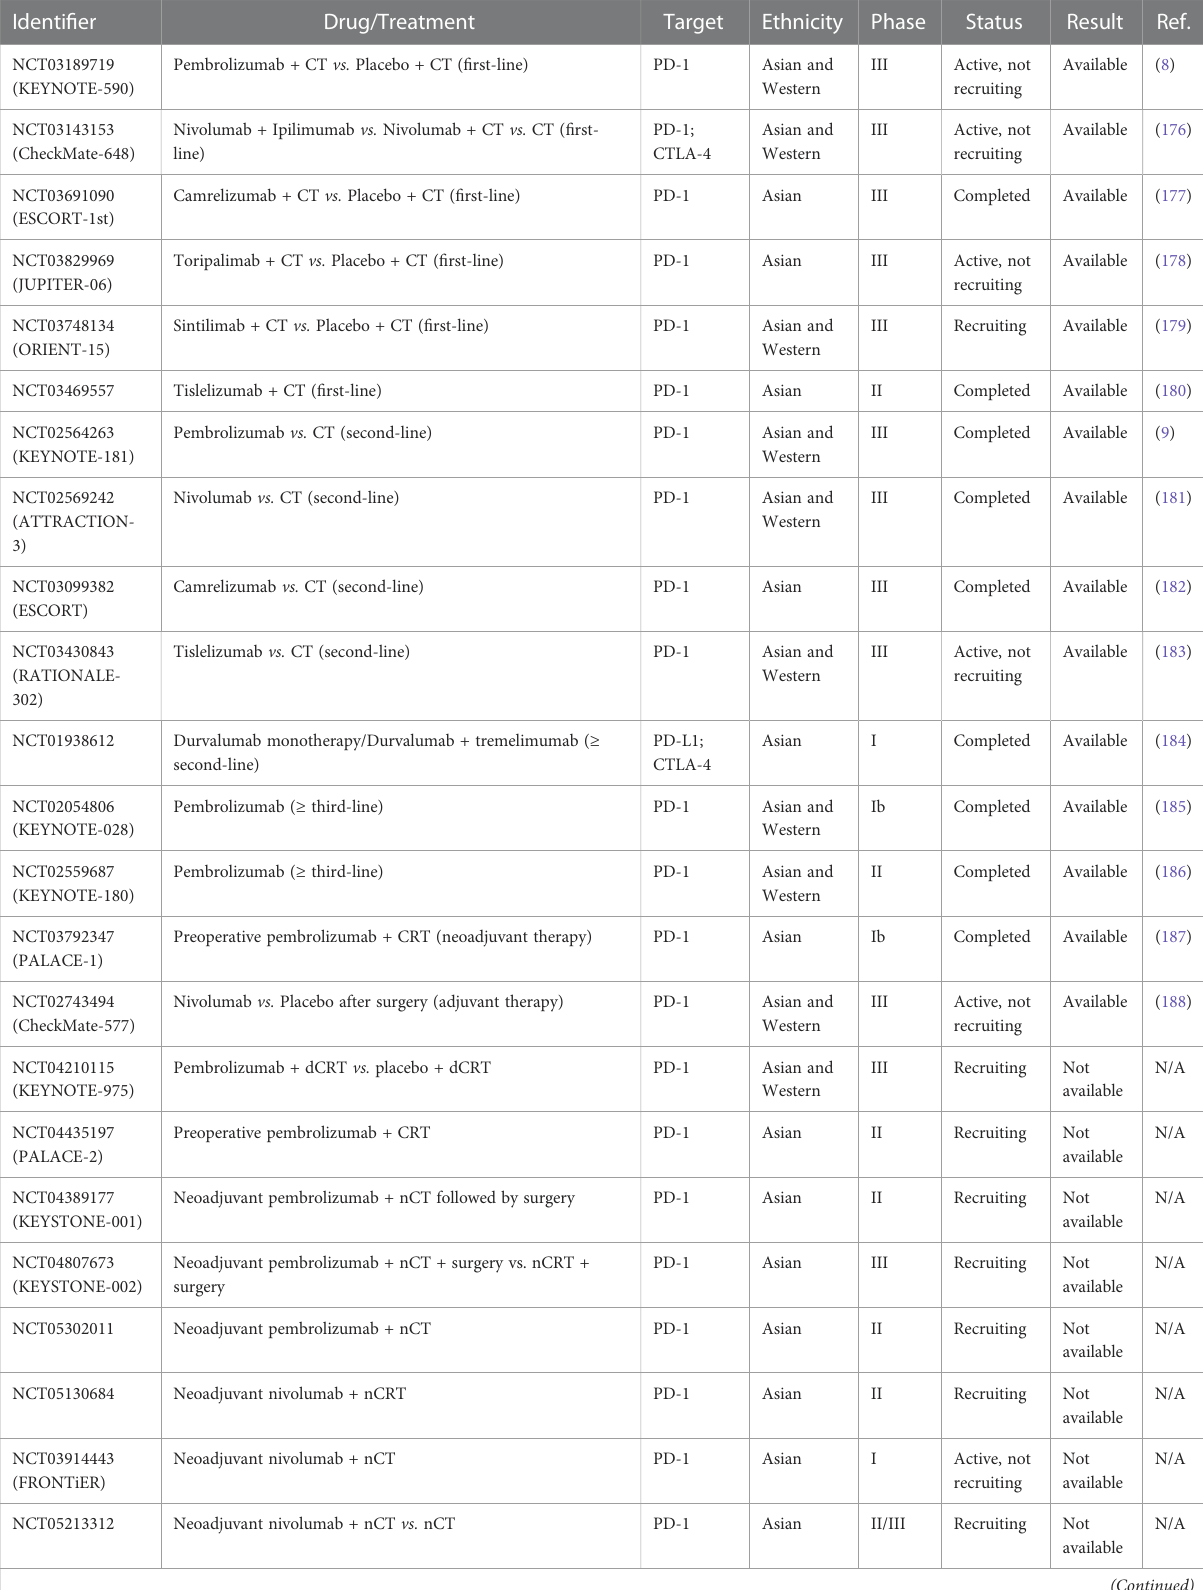
TABLE 1 Overview of clinical trials with immunotherapies targeting immunosuppressive TME in